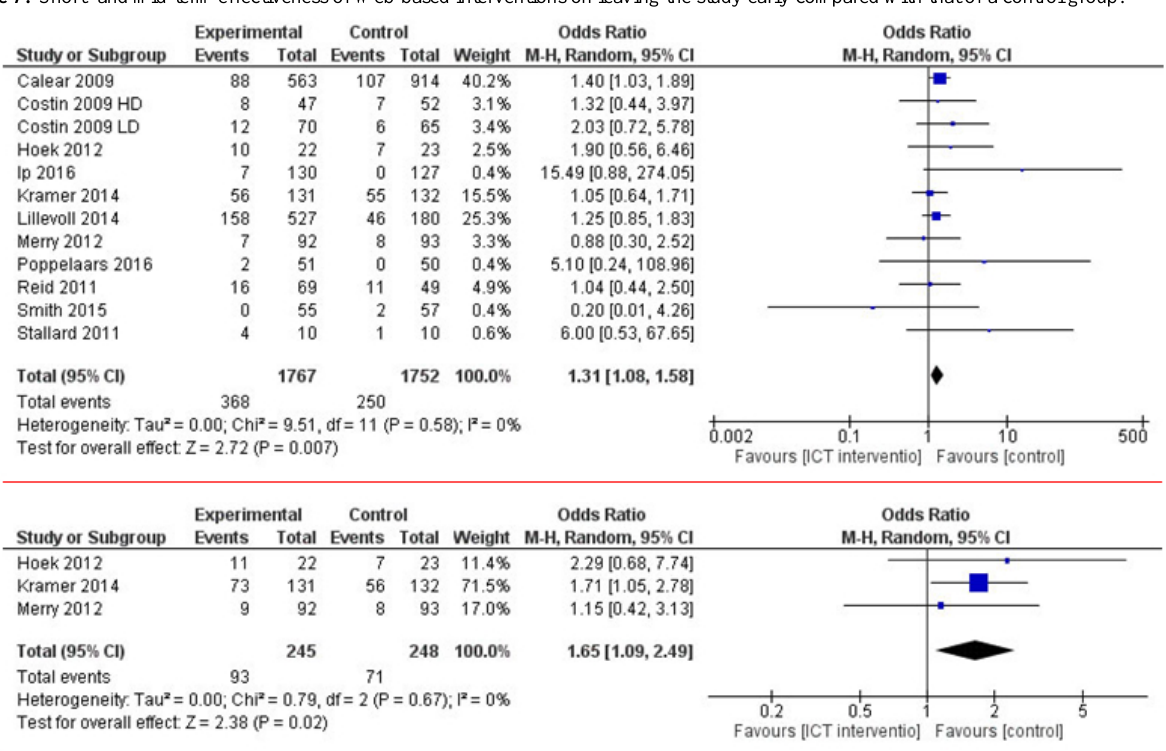
Figure 7. Short- and mid-term effectiveness of Web-based interventions on leaving the study early compared with that of a control